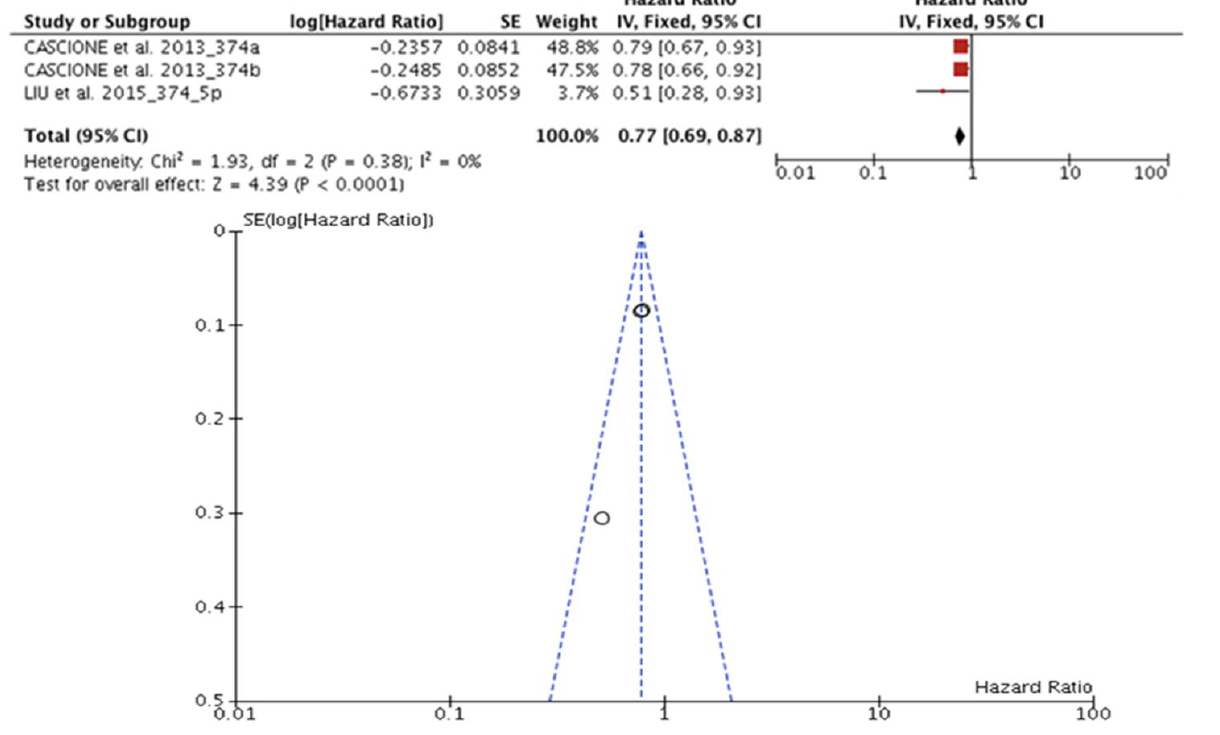
Figure 5. miR-374 and prognosis in TNBC. Forest and funnel plot showed effect of miR-374 downregulation was associated with a shorter DFS (HR: 0.77; 95% CI: 0.69 – 0.87; I2 = 0%, p = 0.38), Z = 4.39 (p < 0.0001) [36,51].